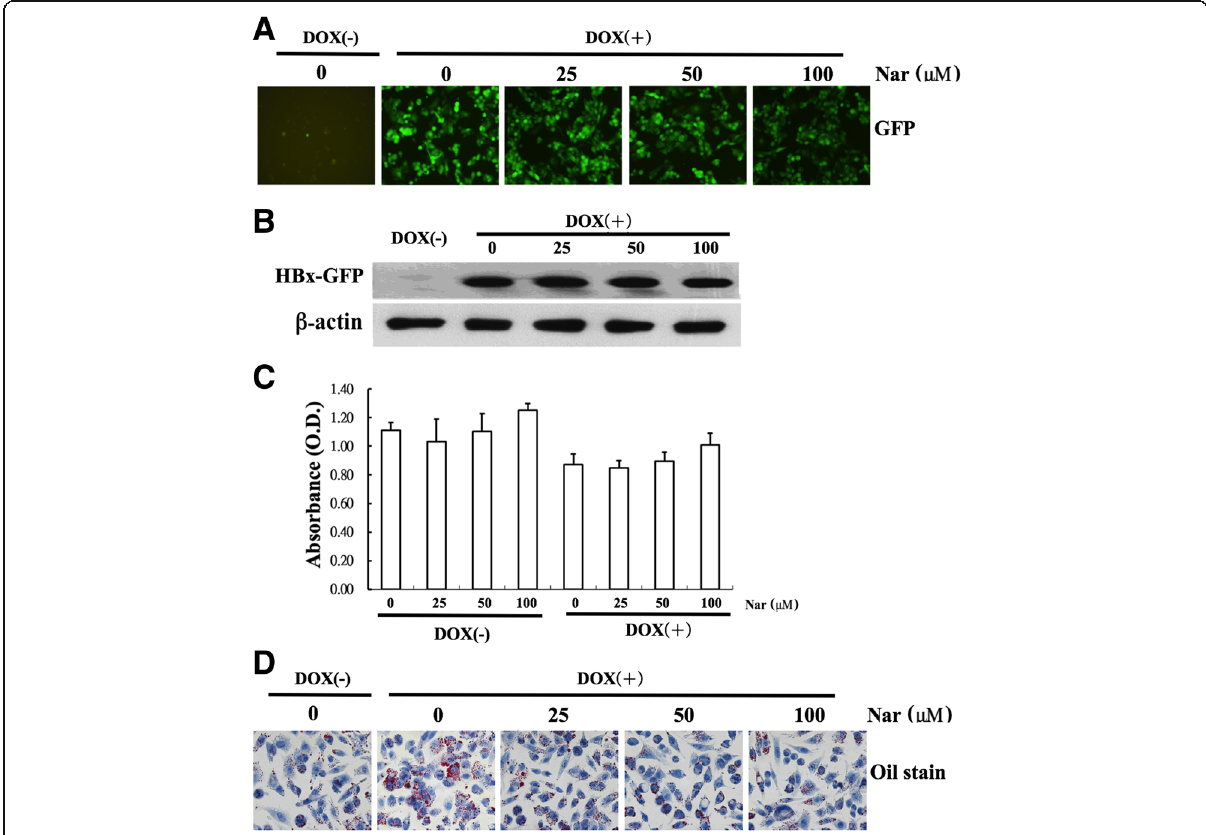
Fig. 3 Establishment of constitutive HBx expression and Oil red-O staining in HepG2 cells. HepG2 cells were transfected with pRT-HBx-GFP. HepG2-HBx-GFP cells with and without DOX were observed under a fluorescence microscope ( a ). Expression of the HBx-GFP fusion protein in HepG2-HBx-GFP cells with and without DOX treatment (DOX( − ) and DOX(+), respectively) was determined by western blot analysis using a GFP- specific antibody. β -actin was included as an internal control ( b ) After selection of G418-resistant colonies, cell proliferation with and without DOX treatment and with and without naringenin (Nar, at the indicated concentrations) was assessed by MTT assay ( c ). HepG2-HBx-GFP cells with and without DOX were treated with or without Nar at the indicated concentrations for 24 h. Intracellular lipid droplets in HepG2 cells were stained with Oil Red O and visualized by light microscopy (Olympus, Tokyo, Japan) ( d